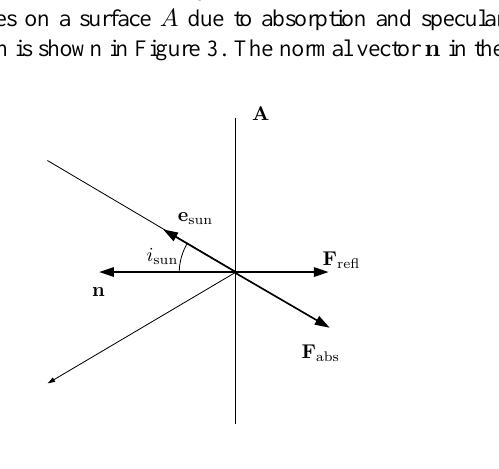
Figure 3: Orbital perturbation forces due to solar radiation pressure for absorbing and reflecting surfaces.